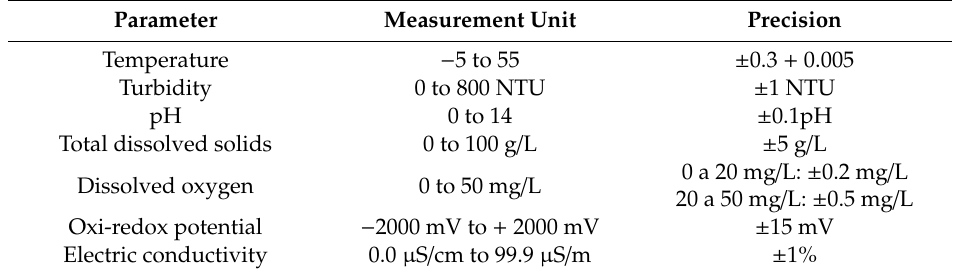
Table 2. Parameters measured by the Horiba U-50 model probe and their measurement units and